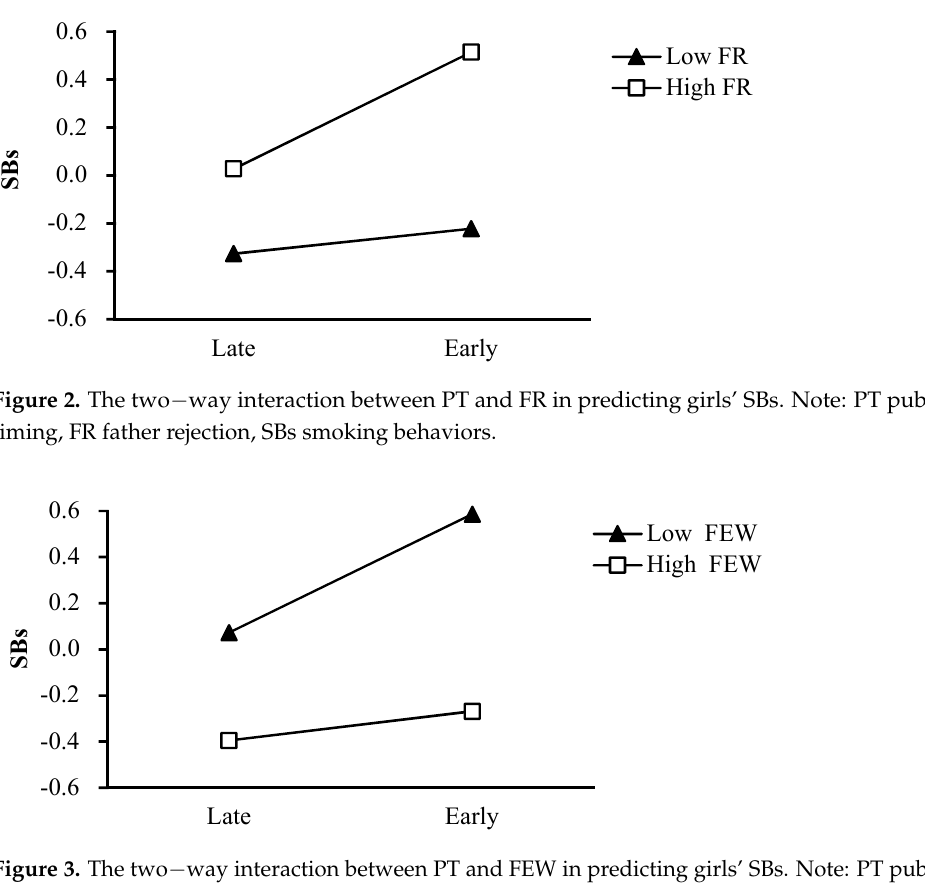
Figure 1. The two−way interaction between PT and FR in predicting boys’ SBs. Note: PT pubertal timing, FR father rejection, SBs smoking behaviors.